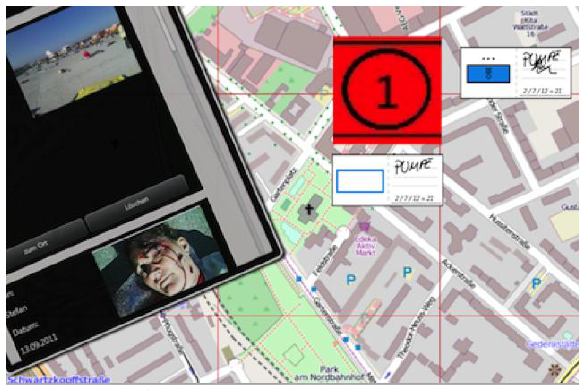
Fig. 6: Georeferenced images, damage accounts and assigned units